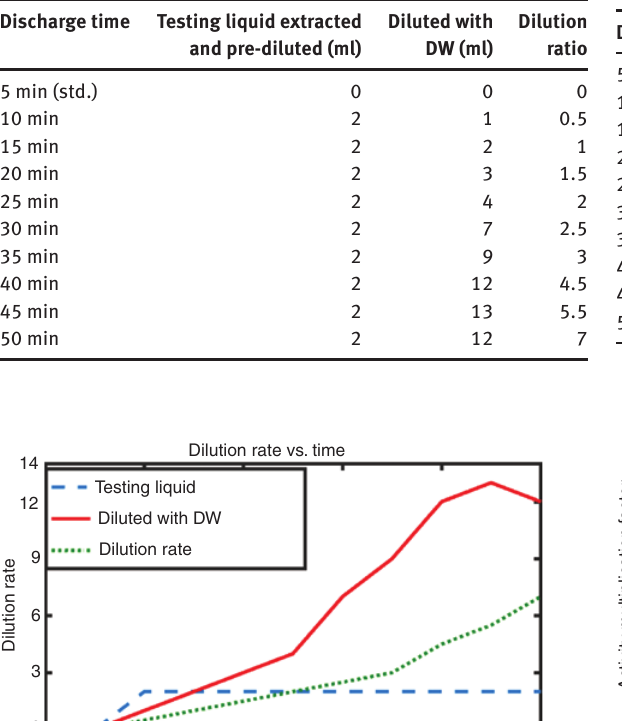
Table 4: The activity multiplication factor.